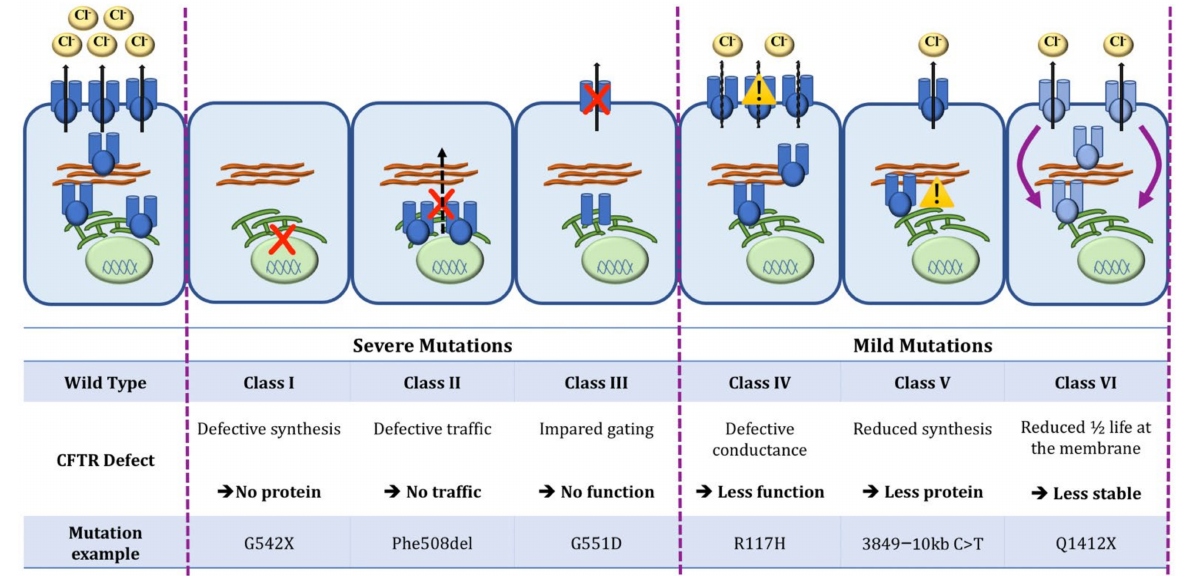
Figure 1. Classification of CFTR mutations. CFTR protein is located at the apical surface of epithelial cells, where it acts as a bicarbonate and chloride (Cl − ) channel. Mutations in the CFTR gene are classified as severe (Classes I, II, and III), resulting in absent or minimal CFTR function, and mild (Classes IV, V, VI), usually with residual CFTR